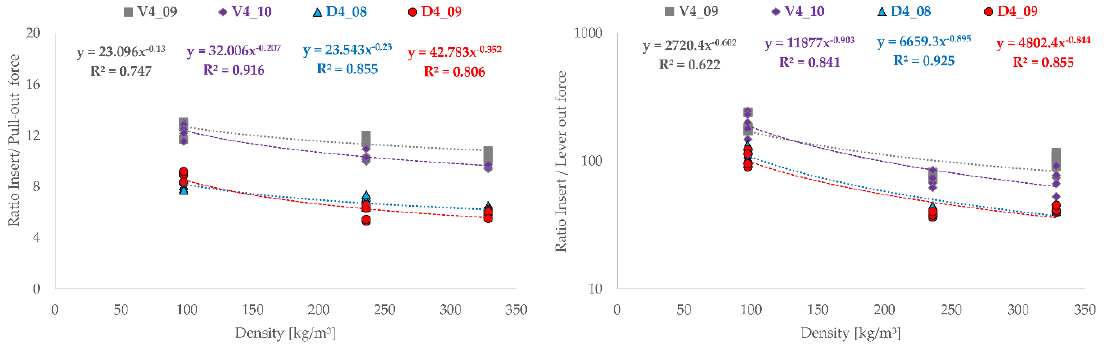
Figure 4. Representation of press-in ratio to the forces determined experimentally for the pull-out test and lever-out test in comparison to the material density (SikaBlock = 236 kg/m 3 , Sawbones = 328.6 kg/m 3 and ROHACELL = 97.6 kg/m 3 ) of the artificial bone cavities (n = 5).